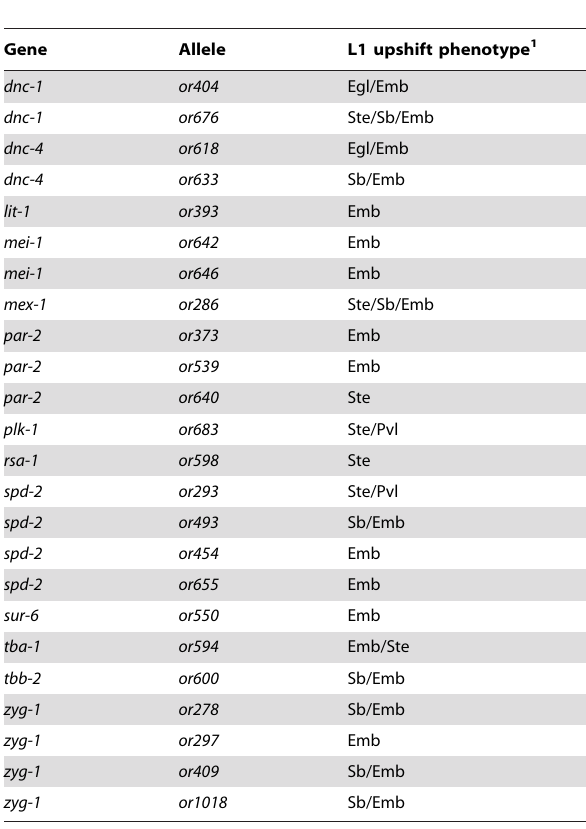
Table 4. The phenotypes of the TS mutants when grown at the restrictive temperature from the L1 larval